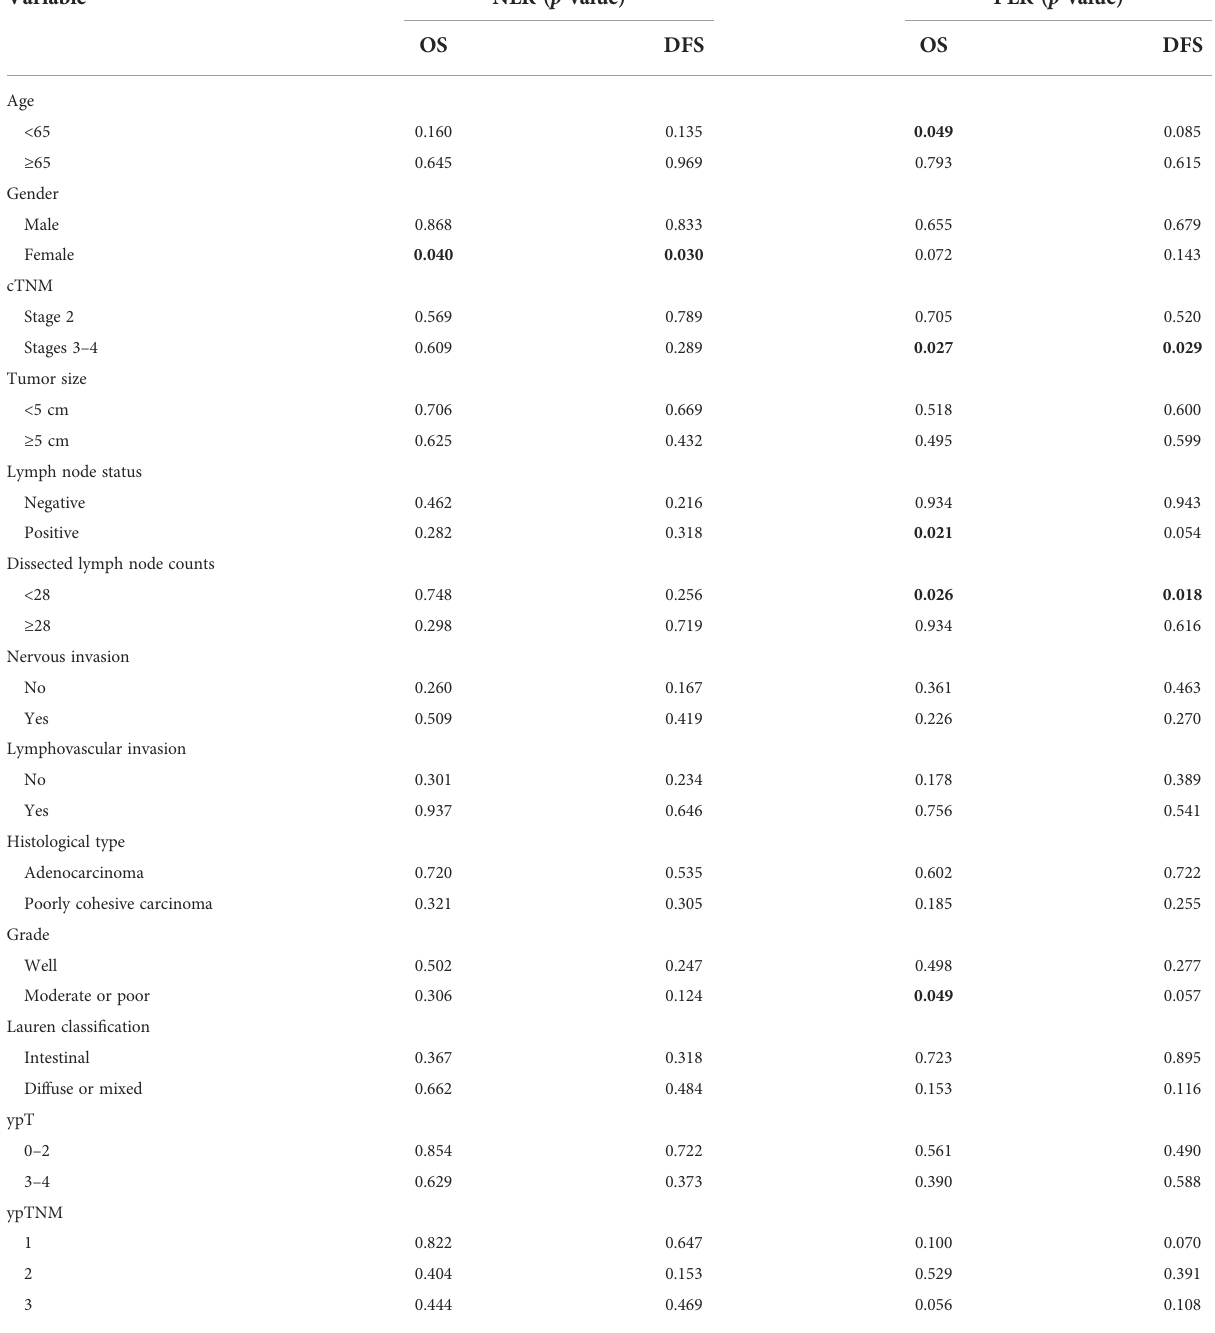
TABLE 5 Strati fi ed survival analysis of baseline